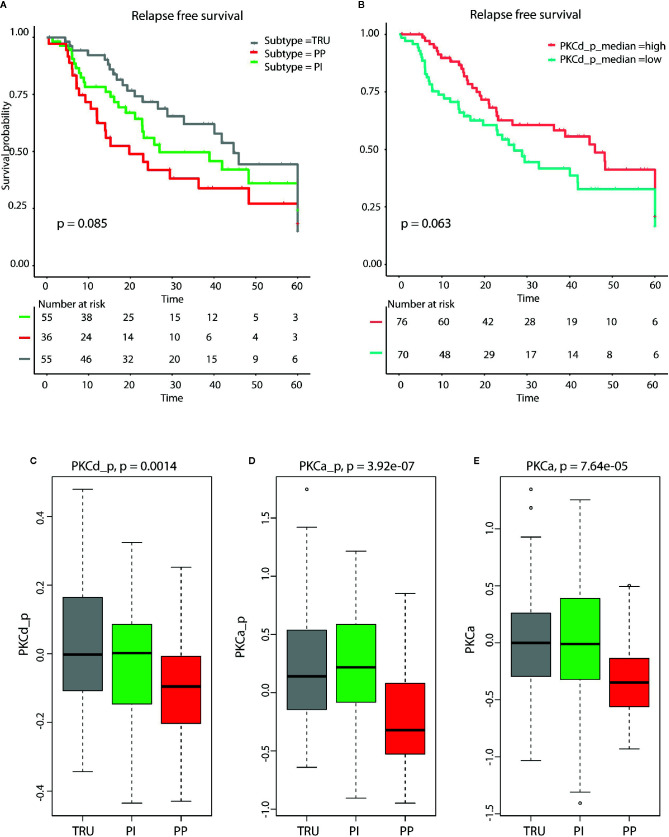

(A) Kaplan Meyer survival plot demonstrate reduced relapse free survival in patients with PP subtype (p = 0.085). (B) Kaplan Meyer survival plot shows that low levels of phosphorylated PKCd (p= 0.0683, log rank test) are associated with reduced relapse free survival. The molecular subtypes terminal respiratory unit (TRU), proximal inflammatory (PI), and proximal proliferative (PP) display different levels of (C) phosphorylated PKCδ, (D) phosphorylated PKCα, and (E) PKCα. The lowest level is seen in the PP samples for all three proteins. These results are calculated from lung adenocarcinoma (LUAD) samples in The Cancer Genome Atlas (TCGA).